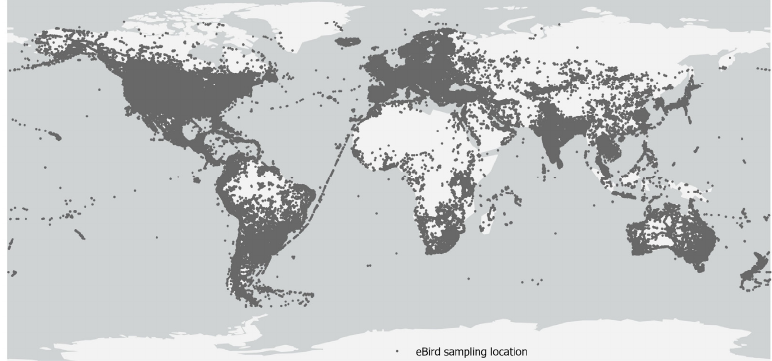
Figure 6. eBird sampling event locations in 2021 ( n = 13,806,513).